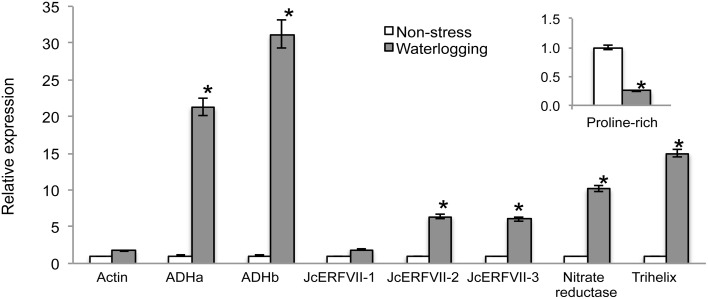
Quantitative real-time PCR validation of transcriptome data for selected genes. Relative expression was normalized to the abundance of Ubiquitin (UBC; Jcr4S00238.120). Data represent mean ± SE (n = 3). *p-value < 0.01 (t-test).